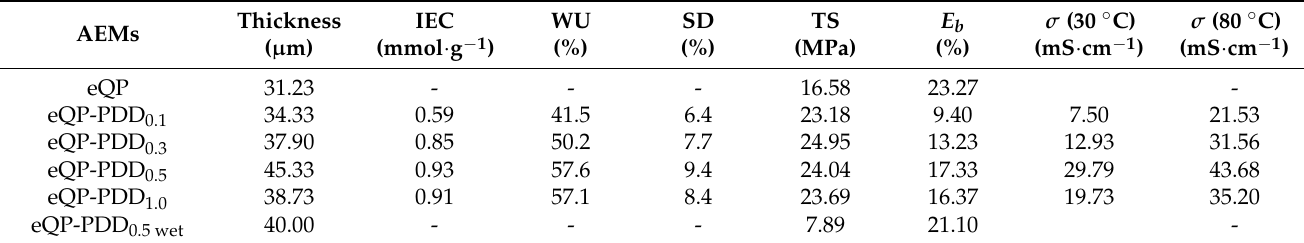
Table 3. Physicochemical parameters of eQP-PDD x